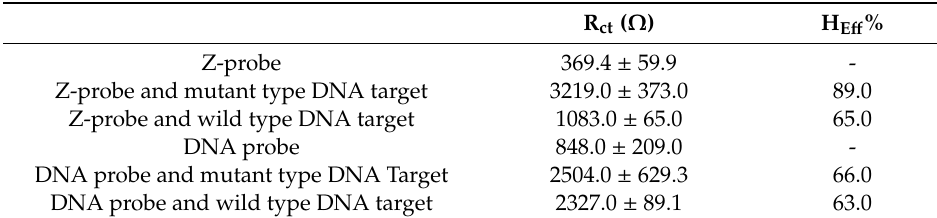
Figure 3. The hybridization between 1.0 µ g mL − 1 ( A ) Z-probe, or ( B ) DNA probe and 12.0 µ g mL − 1 . mutant type DNA or wild type DNA target. Nyquist diagrams related to (a) Z-probe or DNA probe in the absence of target, the hybrid form of Z-probe, or DNA probe with (b) mutant type DNA target, (c) wild type DNA target. Table 2. The average R ct values measured with the hybrid form of the Z-probe or DNA probe with mutant type DNA target/wild type DNA target and H Eff % values.